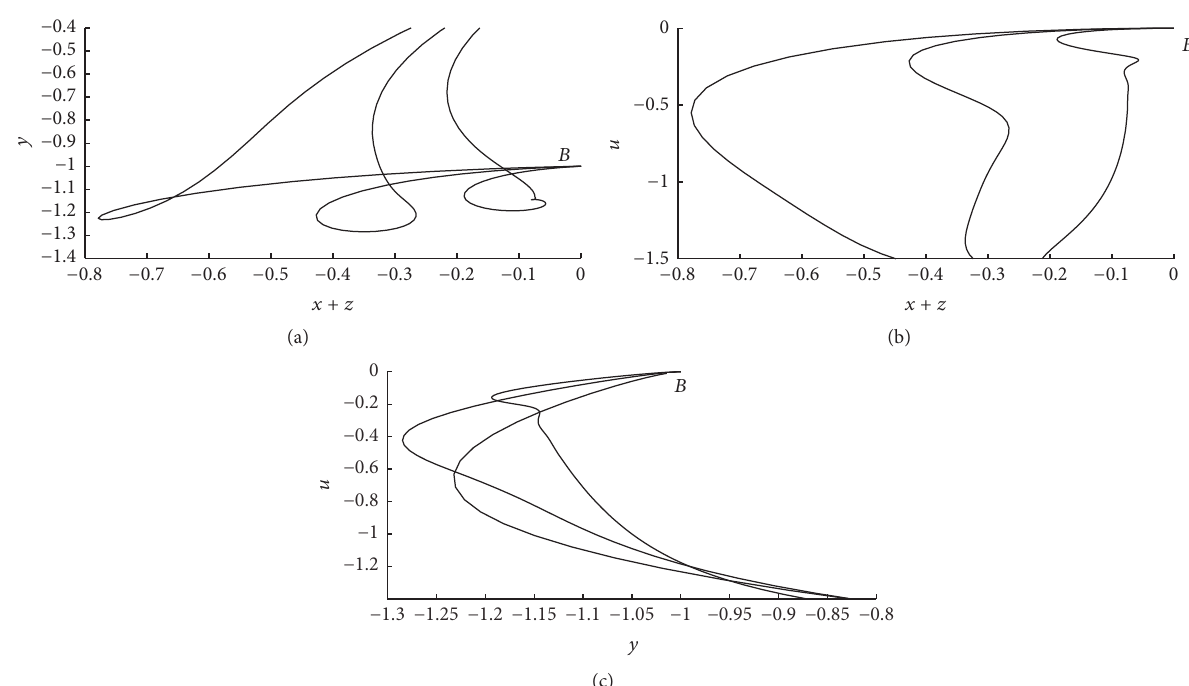
Figure 2: Two-dimensional projections of the phase-space trajectories for stability condition 𝜉 = 0.15 and for present day values 𝛽 = 14.5 , = 0.3 . All plots begin from the critical point 𝐵 being a stable attractor. 𝛾 = 1.5 , and Ω 𝑚